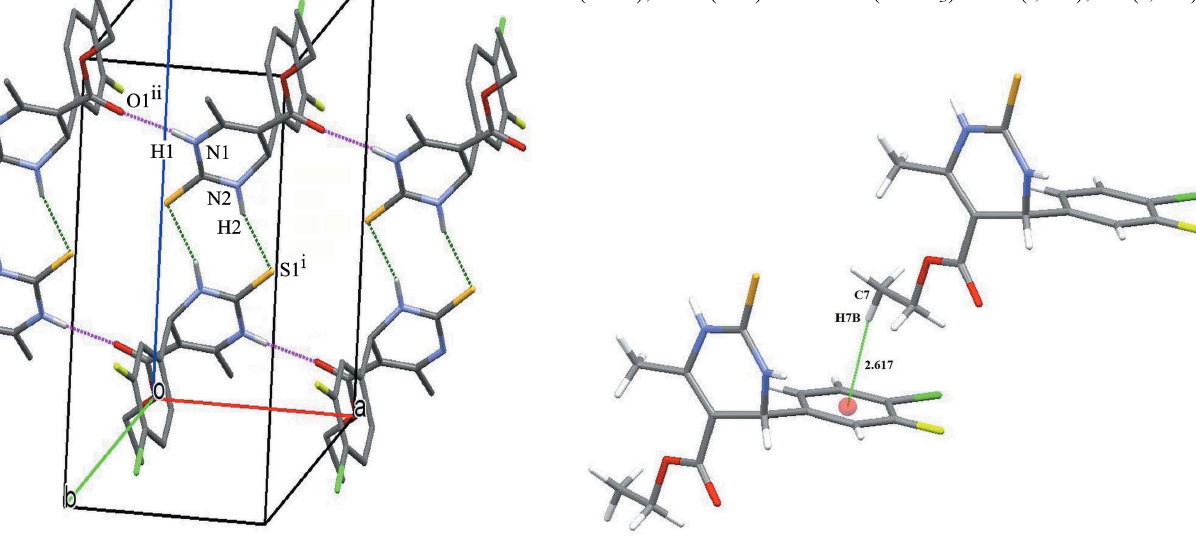
Figure 4 Unit-cell packing depicting the C—H (cid:3)(cid:3)(cid:3) (cid:2) interaction as a dotted